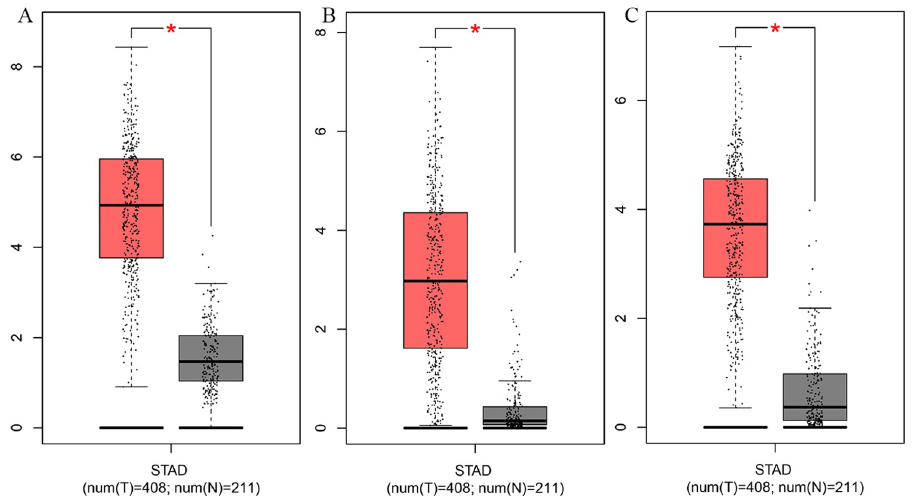
Fig 6. Verification of the expression levels of these 3 hub genes using GEPIA. (A) CTHRC1 (B) FNDC1 (C) INHBA .